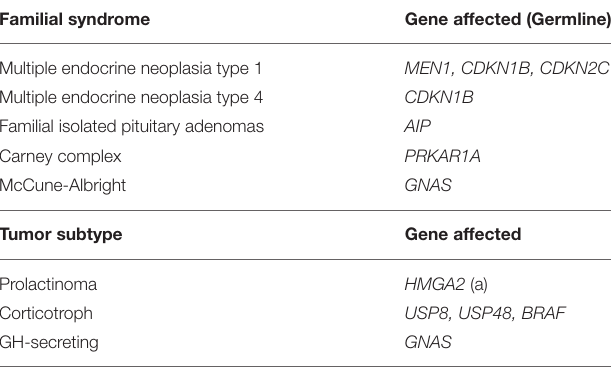
TABLE 2 | Familial and somatic mutations associated with pituitary